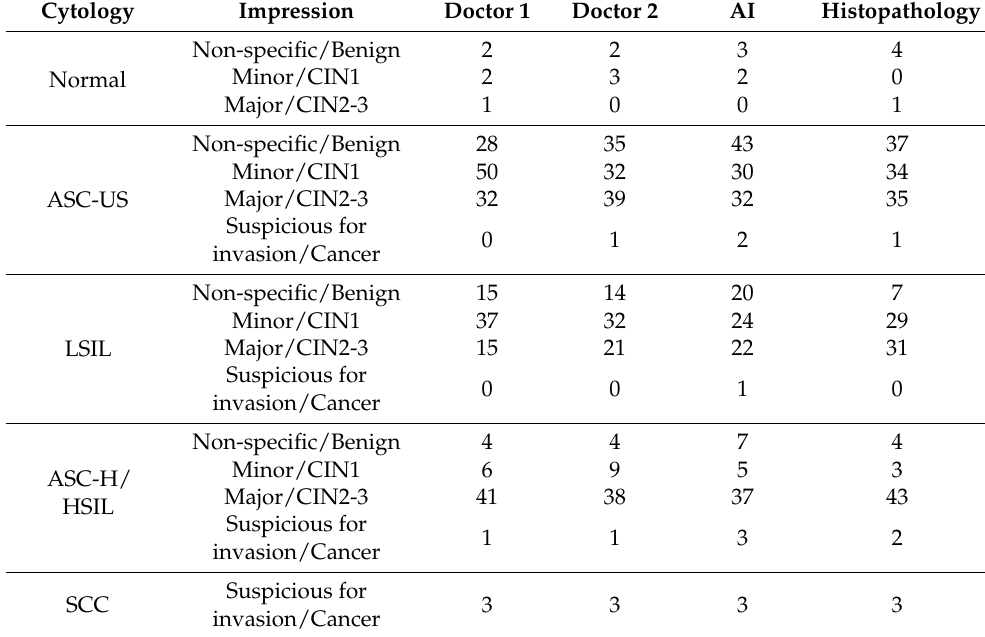
Figure 2. ROC curves of each diagnostic performance for detecting high-grade or worse lesion versus less severe impressions. (a) AI interpretation; (b) colposcopic impression of Dr 1; (c) colposcopic impression of Dr 2; (d) combined impression of AI and Dr1 colposcopy; (e) combined impression of AI and Dr2 colposcopy; (f) cytology. Table 2. Distribution of the colposcopic findings, AI interpretations, and histopathology according to the cytology